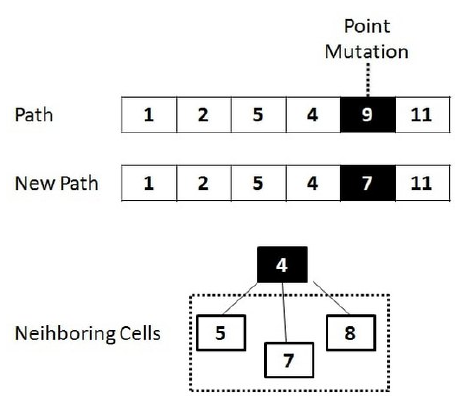
Figure 6: Mutation